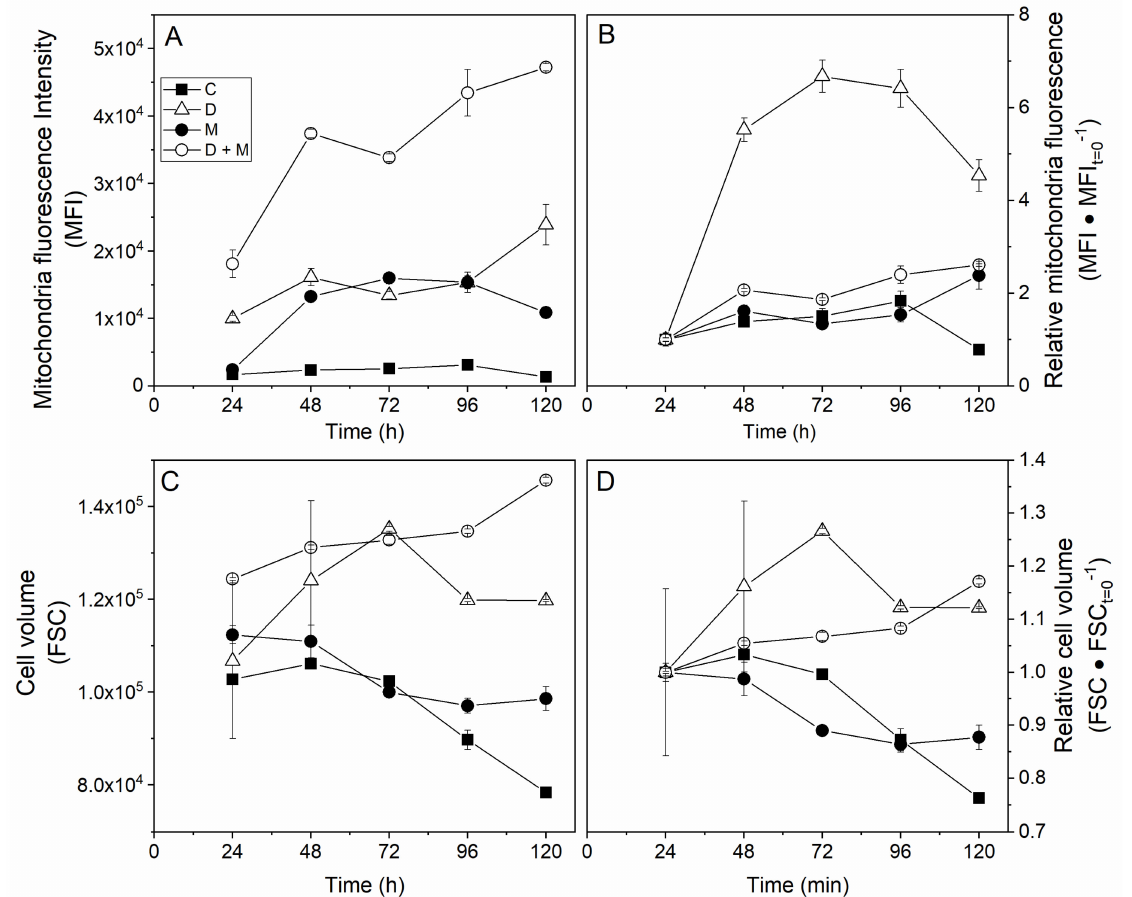
Figure 4. Long-term effects of adding hyperosmotic culture conditions combined with lipoic acid and hydroxycitrate drugs. ( A ) Mean fluorescence intensity (MFI) in a.u., ( B ) relative MFI monitoring, ( C ) cell volume (estimated by FSC in a.u.), and ( D ) relative cell volume for control (filled squares), drug (empty triangles), mannitol (filled circles) and both drug and mannitol (empty circles)